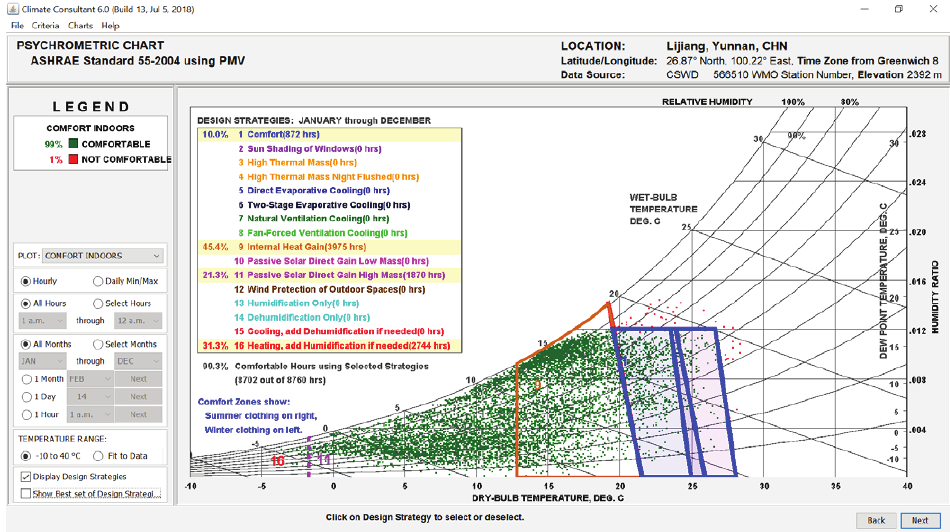
Figure 14. Appropriate building design strategies for Lijiang (diagram generated with Climate Consultant 6.0 (Liggett & Milne, 2020) and EnergyPlus weather data (EnergyPlus, 2020))